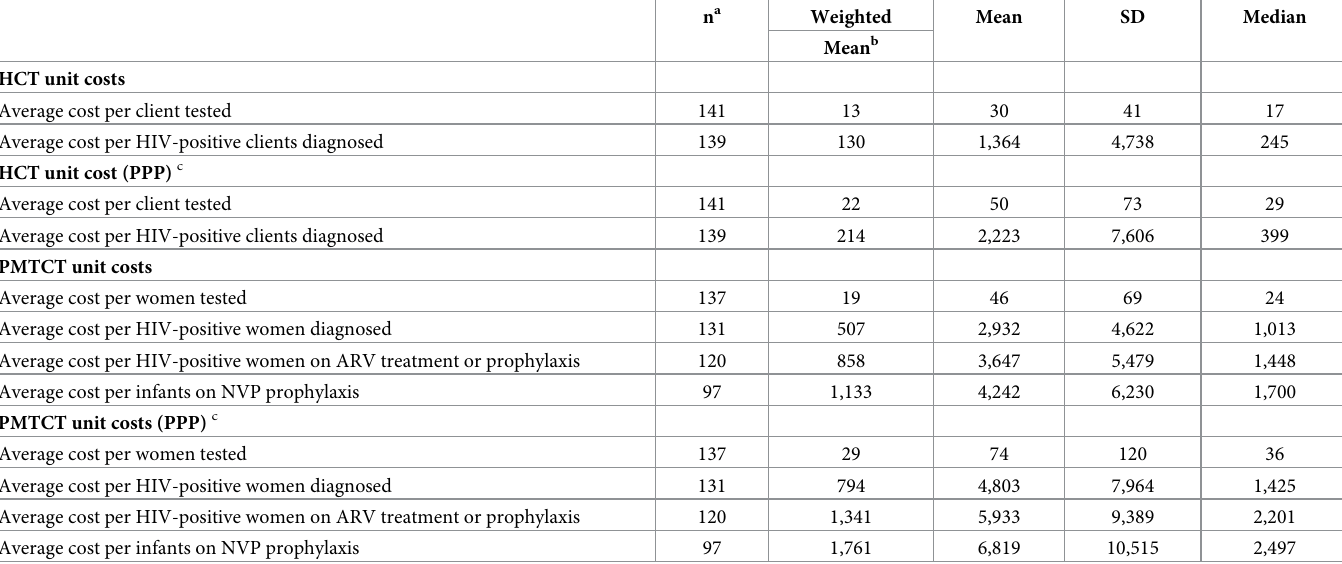
Table 3. Unit costs along the HCT and PMTCT service cascades (US$).